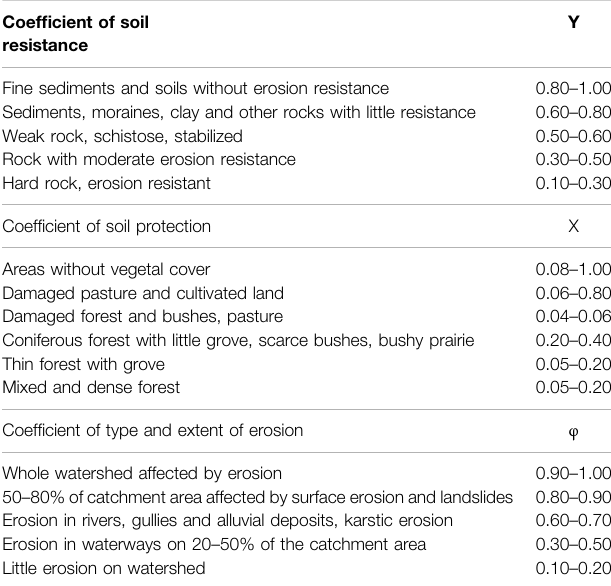
TABLE 4 | Descriptive variables used in the erosion coef fi cient (Z).